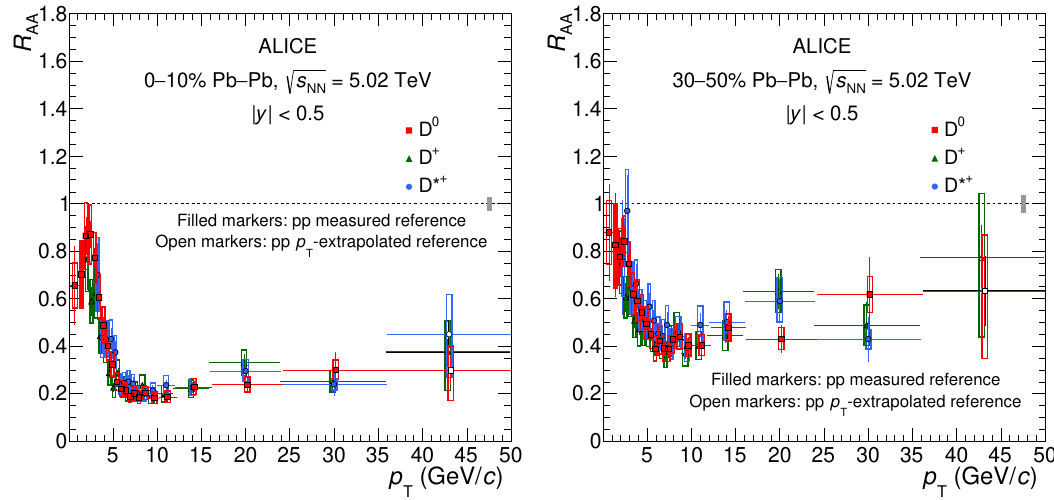
Figure 6 . R AA of prompt D 0 , D + , and D ∗ + mesons as a function of p T for the 0–10% (left panel) and 30–50% (right panel) centrality classes. Statistical (bars), systematic (boxes), and normalisation (shaded box around unity) uncertainties are shown. Filled markers are obtained with the measured pp reference [37, 65], empty markers with the p T -extrapolated